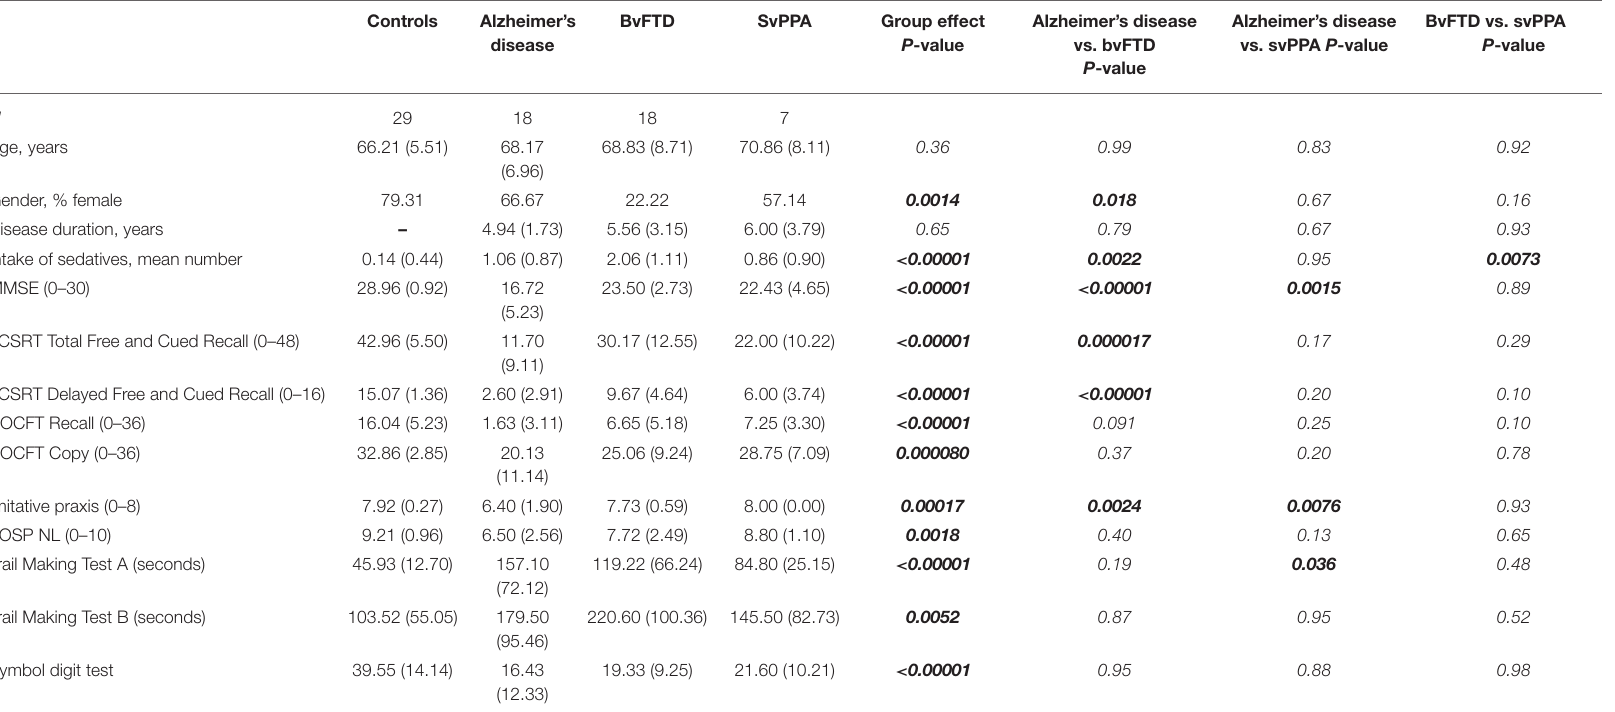
TABLE 1 | Demographics and neuropsychological